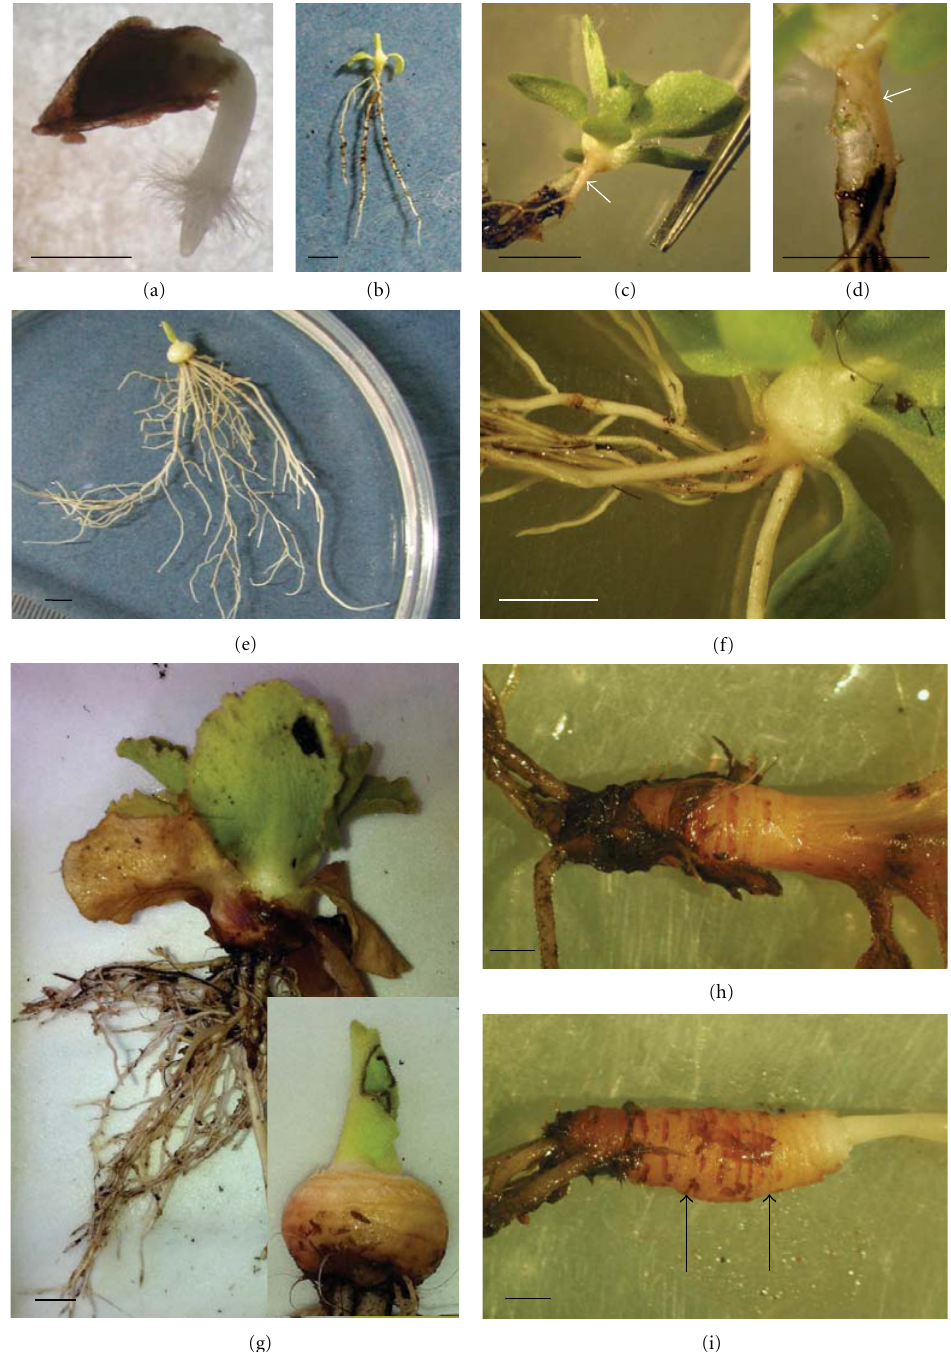
Figure 1: Developmental stages of P. palinuri plants: (a) germinated seeds with emerging root, hypocotyl ring hairs and hypocotyl; (b)–(d) very young plants at 5–7-leaf stage showing the hypocotyl enlarging into a cone in continuity with the primary root ((c), (d) arrows) and vigorous adventitious roots adjacent to the cone; (e)–(g) very young plants at 10-leaf stage showing the hypocotyl expanded into a round organ with numerous adventitious roots emerging from the base; (h)-(i) young plants with elongated hypocotyl becoming a rhizome; arrows show constrictions marking the probable transition between subsequent years/periods of growth. Bars are 1 mm in a and 0.5cm in